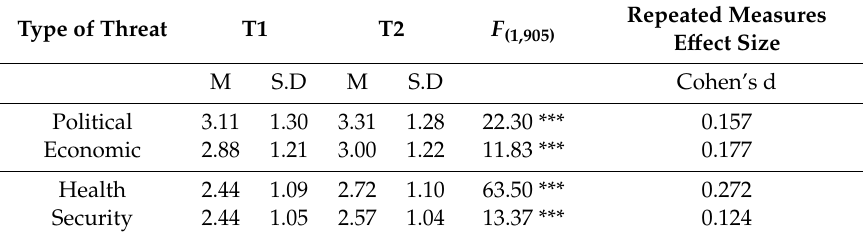
Table 5. General Linear Model: two repeated measures of four